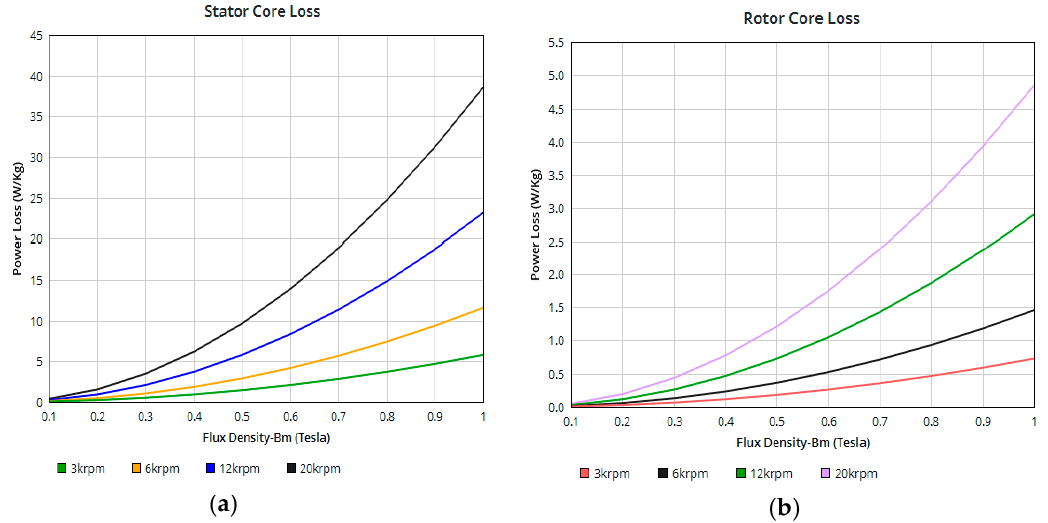
Figure 14. Specific core losses of SCIM-FESS: ( a ) Stator core losses; ( b ) Rotor core losses.